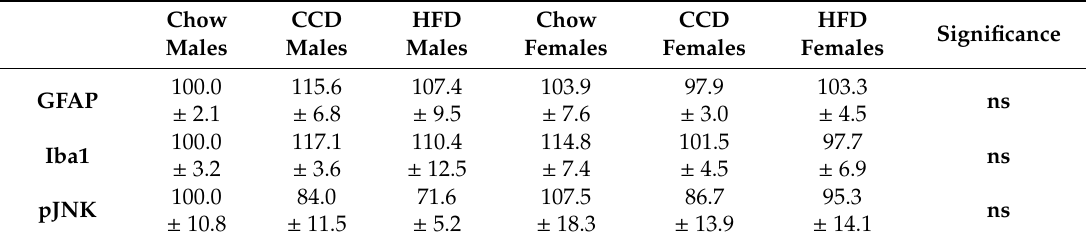
Table 3. E ff ects of 8 weeks on a high-fat diet (HFD), commercial control diet (CCD) or chow diet on glial structural protein (GFAPs: Glial fibrillary acidic protein, Iba1: Ionized calcium binding adaptor molecule 1) and endoplasmic reticulum (ER)-stress markers (pJNK: phosphorylated c-Jun